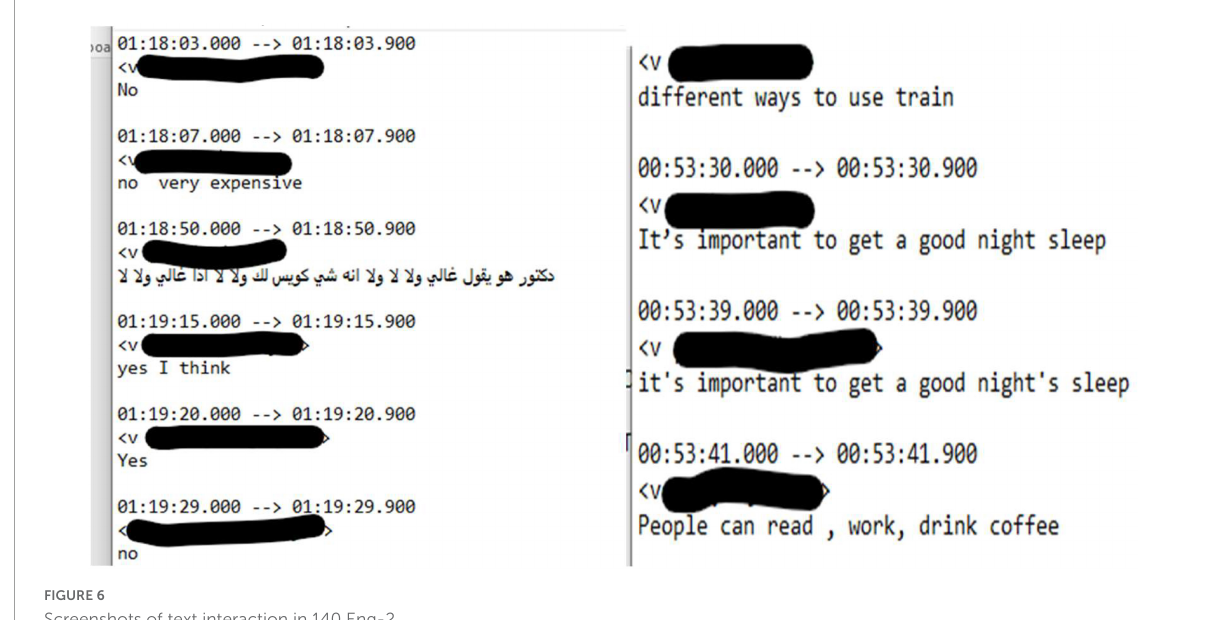
FIGURE6 Screenshots of text interaction in 140 Eng-2.